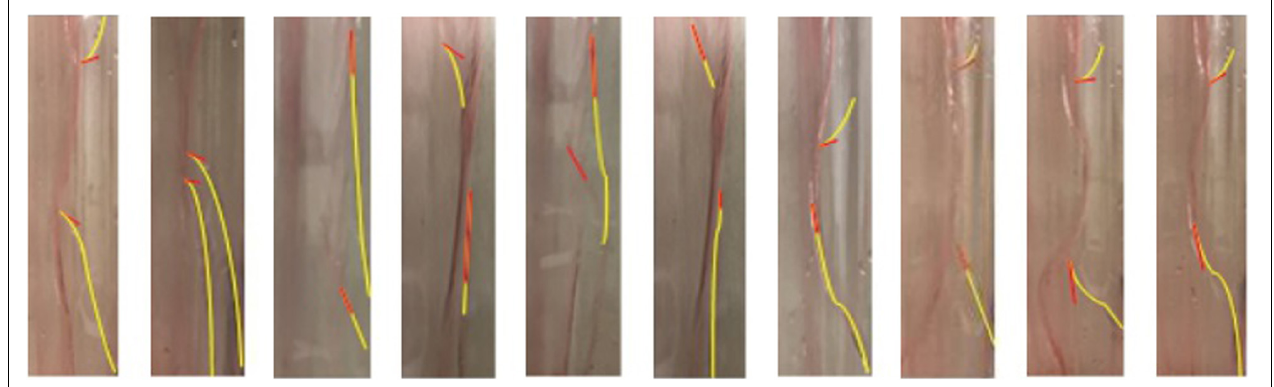
FIGURE 4 | Schematic diagram of two strip-shaped liquid film (TSSLF) for different Reynolds numbers.